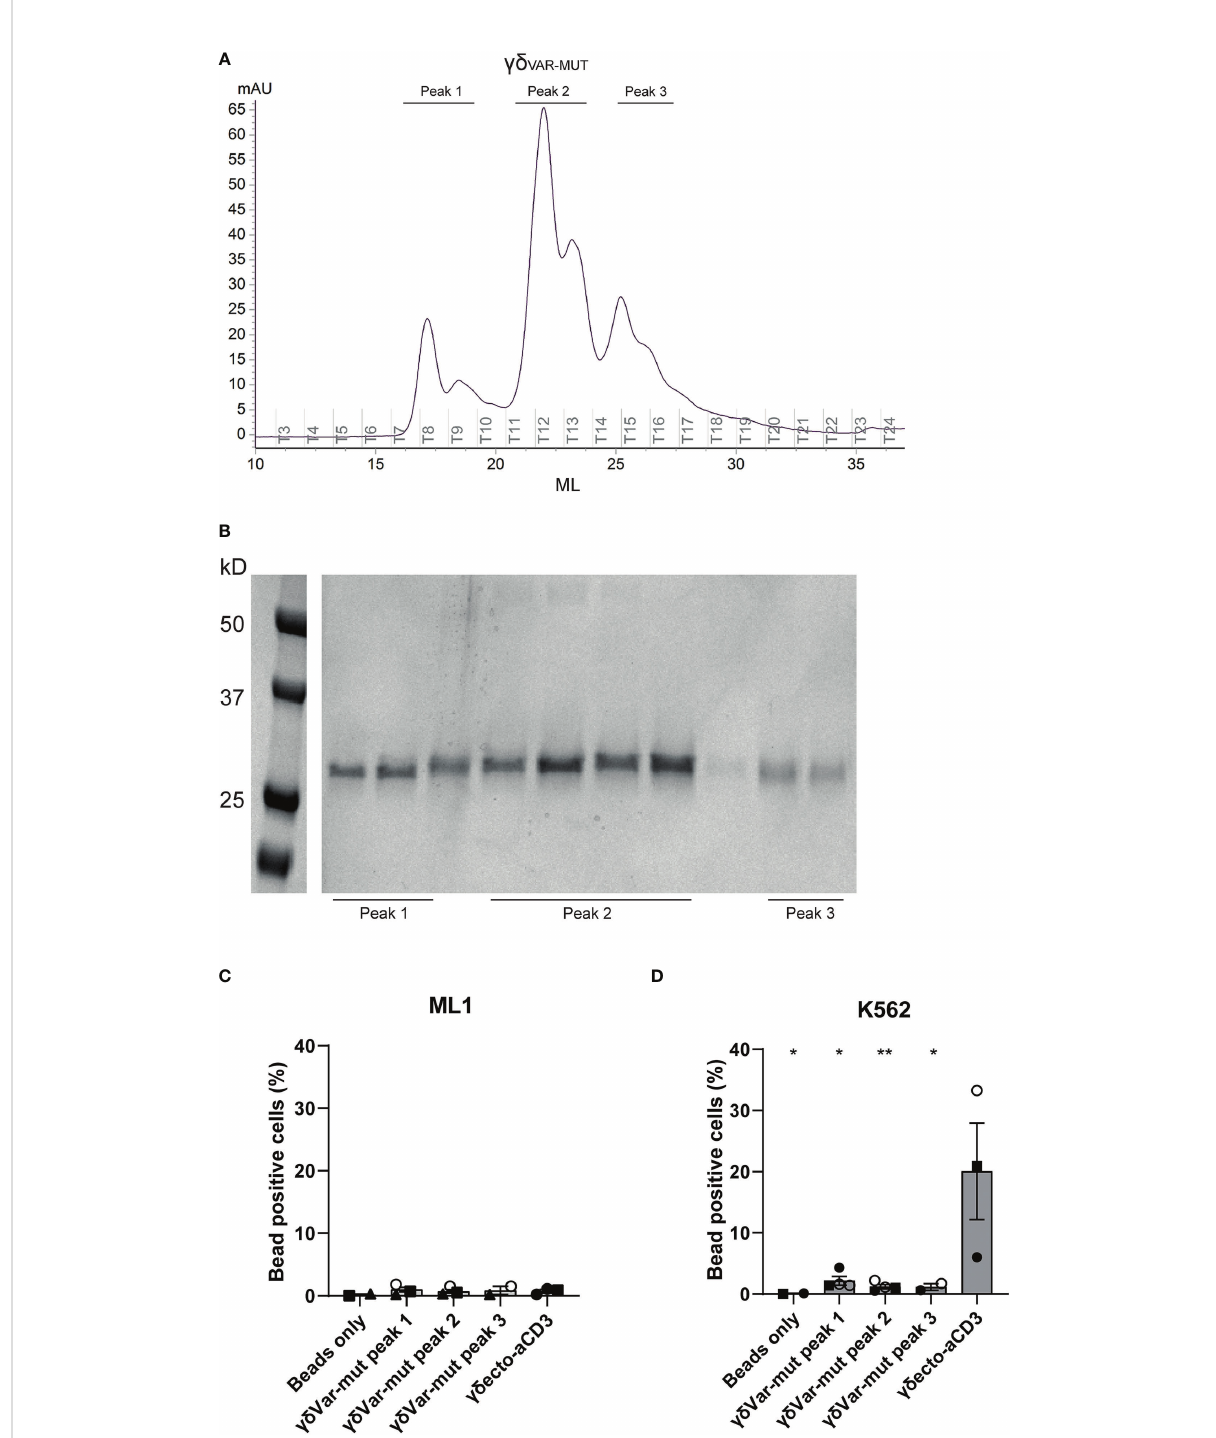
FIGURE 3 Expression and misfolding of single chain gd VAR-MUT . (A) gd var with stabilizing mutations ( gd VAR-MUT ) were expressed in HEK29F cells and puri fi ed using ion exchange chromatography (B) the different protein elution fractions after ion exchange chromatography (IEX) were run on SDS gel and visualized by coomassie brilliant blue staining C/D) Fluorescent beads were coated with the indicated IEX protein elution peaks of gd VAR-MUT or control gd ECTO and incubated with ML1 (C) and K562 (D) cells. Graph shows % beads positive cells. The different symbols represent different experiments. Closed symbols represent protein elution fractions from batch 1, open symbols represent protein elution fractions from batch 2. N=3, error bars represent SEM, signi fi cance was calculated using a multiple comparison one-way ANOVA, comparing all means to the mean of gd ecto, *=p ≤ 0.05 **= p ≤